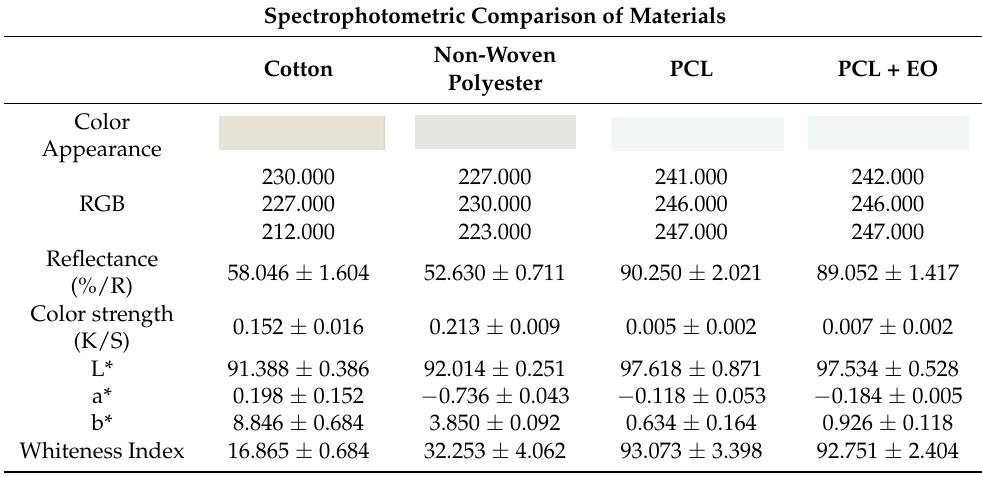
Table 2. Characterization and spectrophotometric comparison of produced and control materials. Table 2 . Characterization and spectrophotometric comparison of produced and control materials. Table 2 . Characterization and spectrophotometric comparison of produced and control materials. Table 2 . Characterization and spectrophotometric comparison of produced and control materials. Table 2 . Characterization and spectrophotometric comparison of produced and control